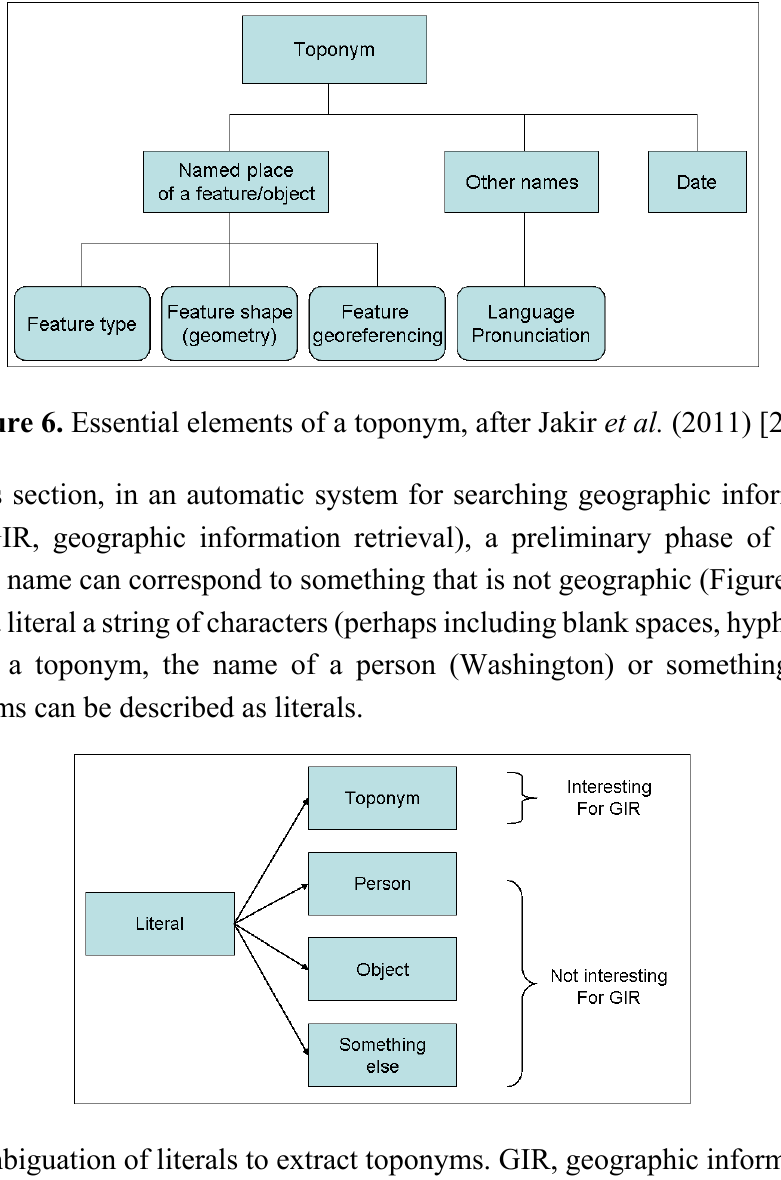
Figure 7. Disambiguation of literals to extract toponyms. GIR, geographic information